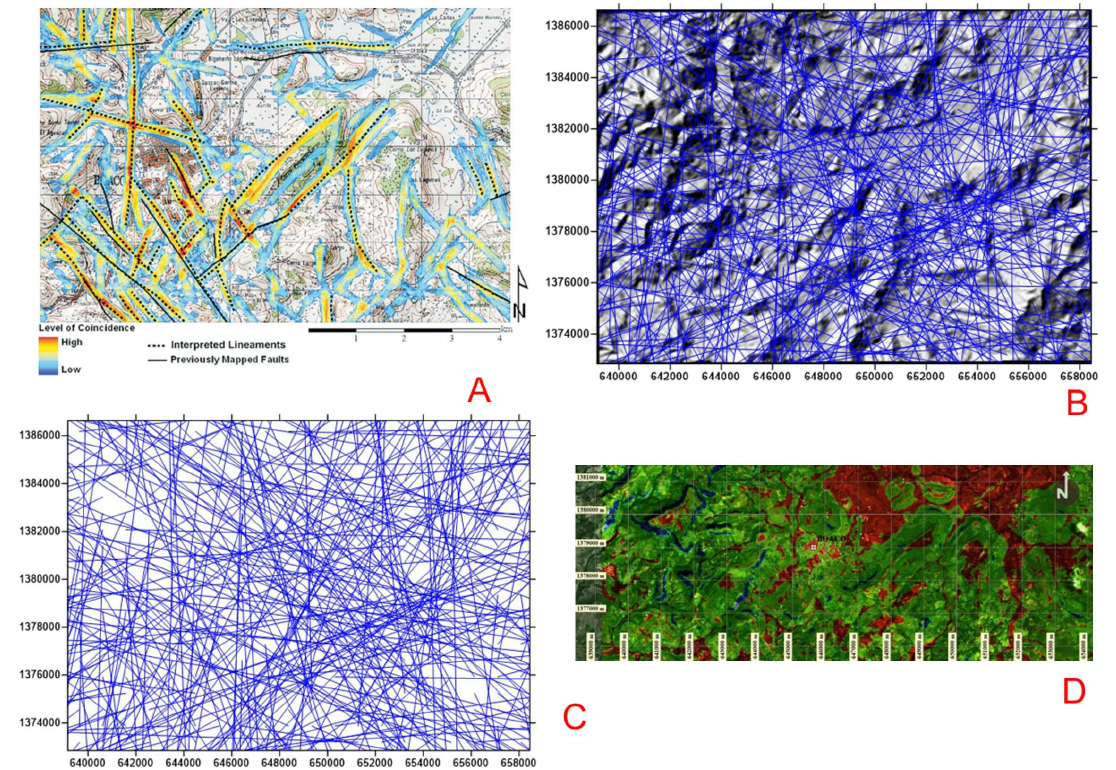
Figure 1. Comparison of structural guidelines obtained with remote-sensing methodology and the proposed methodology applied to the same area (Nicaragua) with the same 20 m spatial resolution digital elevation model. ( A ) Results of the coincidence between the lineaments obtained by remote sensing with stereoscopy. ( B ) Structural guidelines obtained with the proposed method. ( C ) Coincidences and advantages of the proposed methodology. ( D ) Deformed relief.